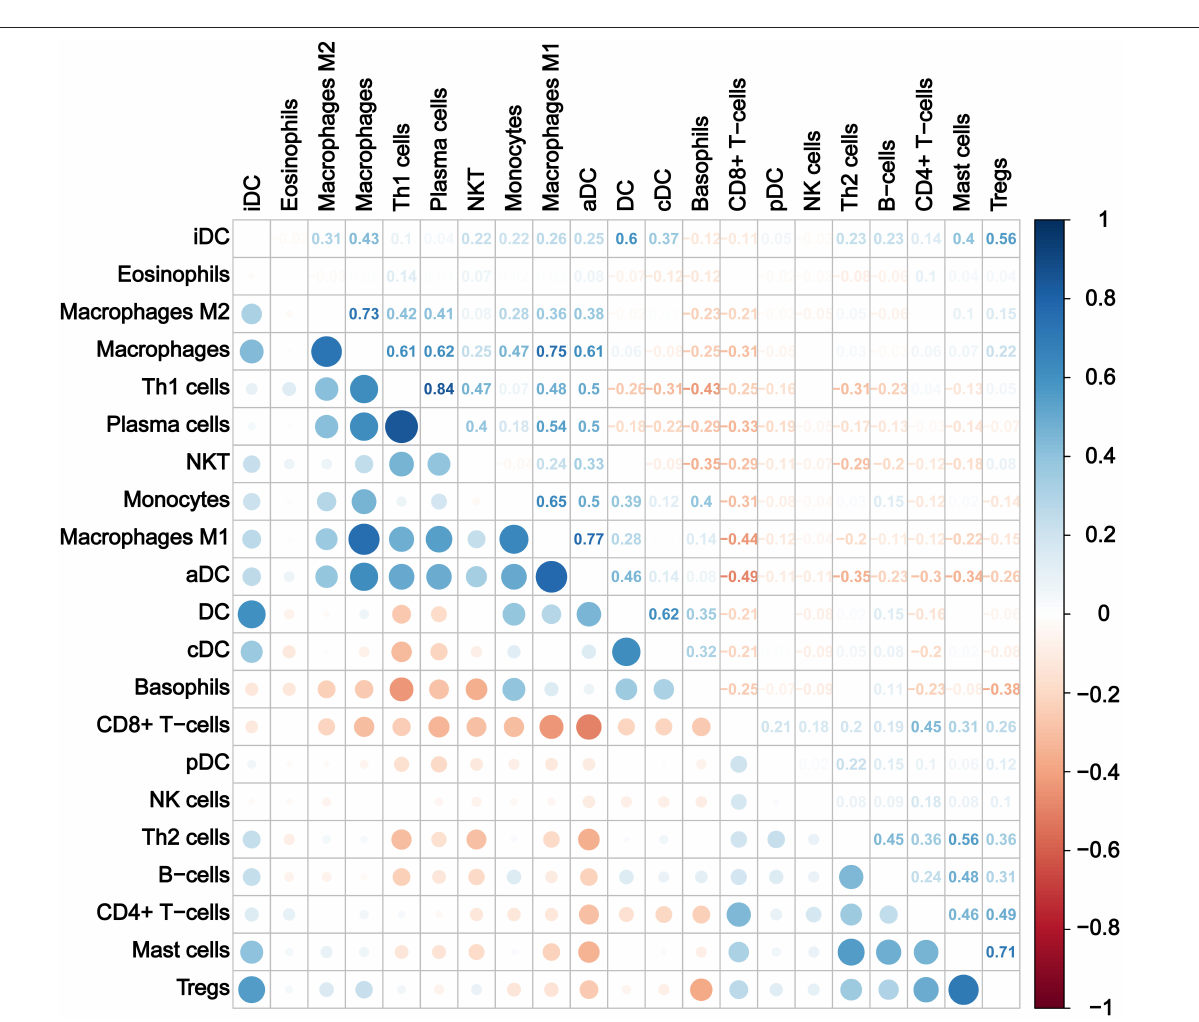
FIGURE 5 | Correlation matrix of immune cell